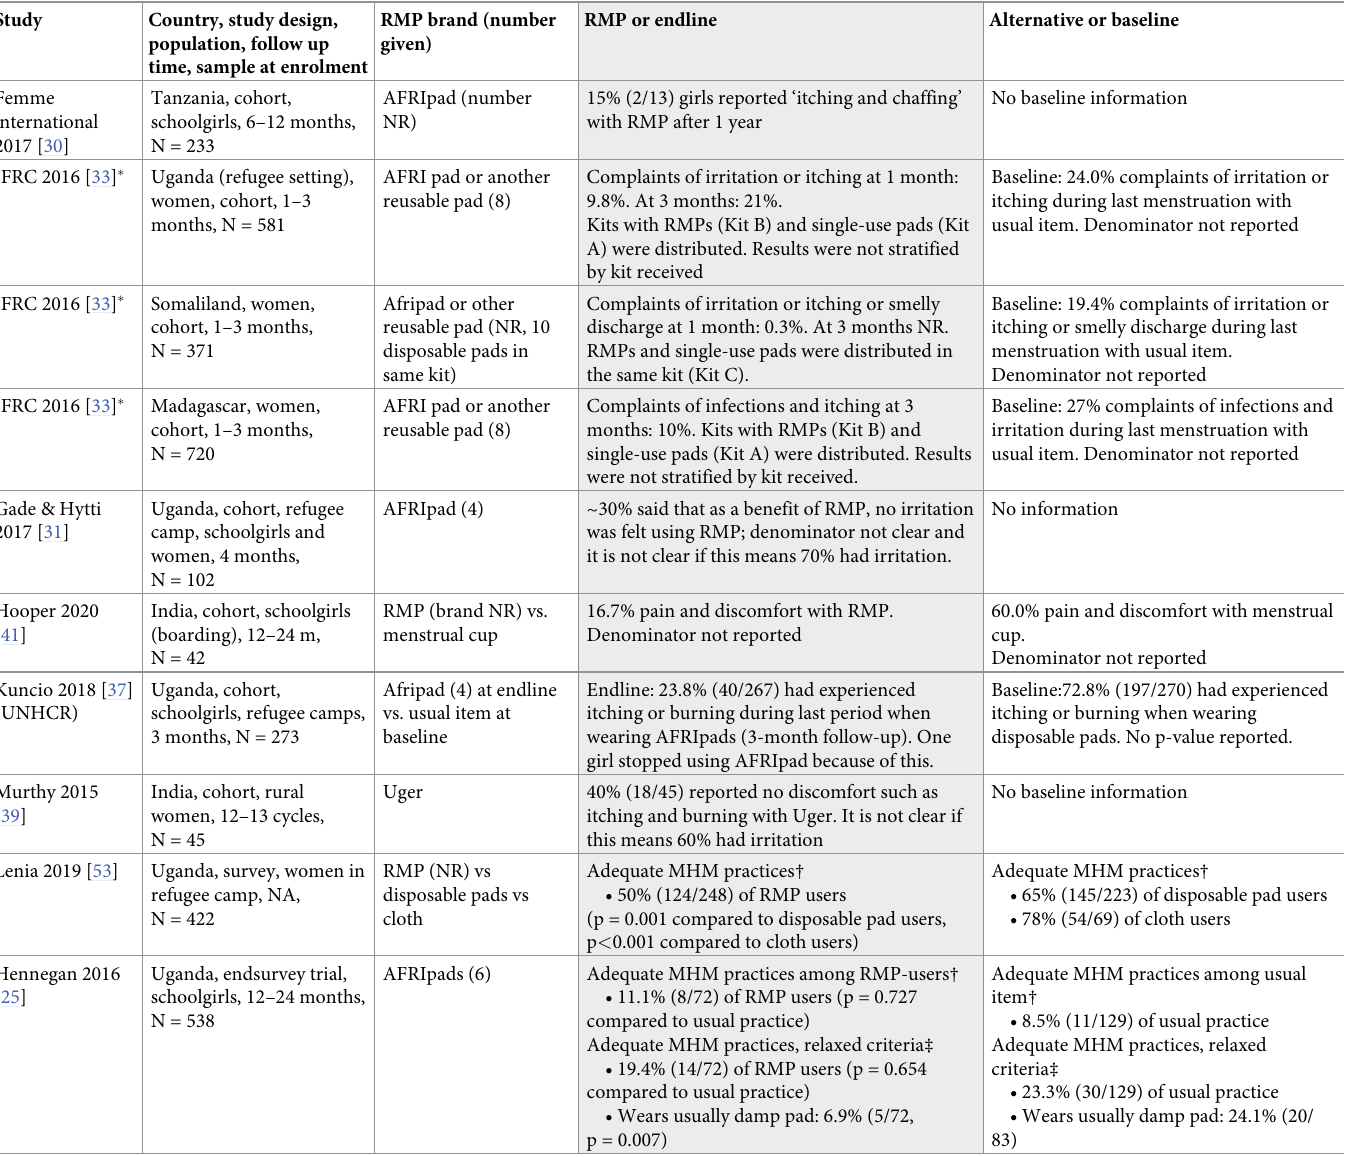
Table 5. Any information that may relate to adverse effects of reusable menstrual